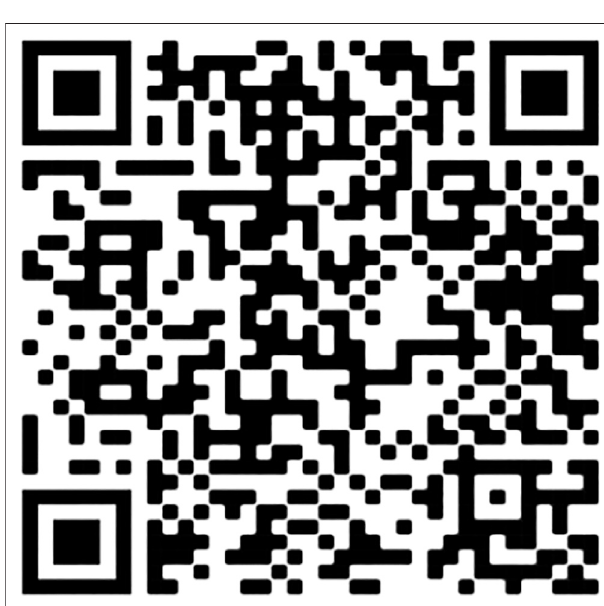
FIGURE 2 | QR code of the category system by progression levels (pretest – posttest). Own elaboration based on the European Commission